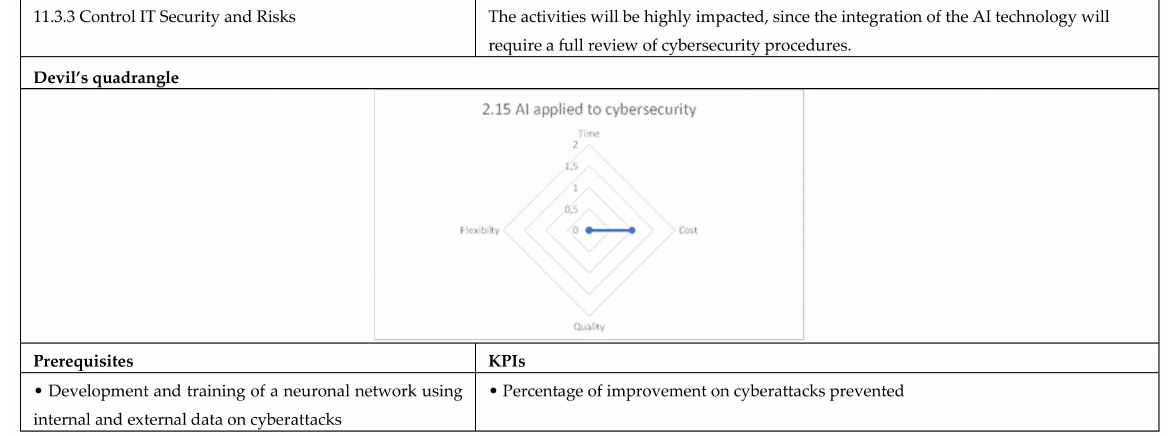
Figure A19. AI applied to cybersecurity data sheet.